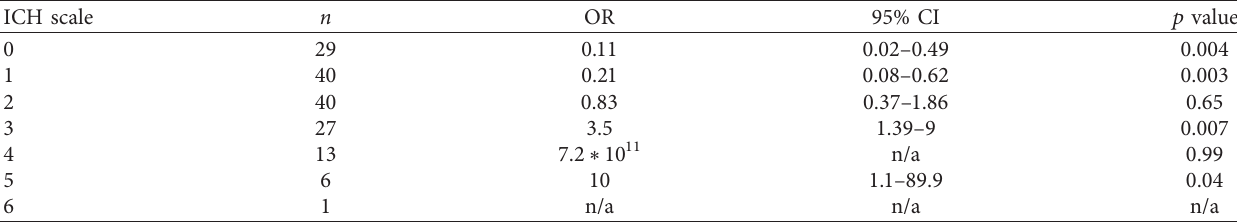
Table 2: Prediction of 30-day mortality death using the ICH scale